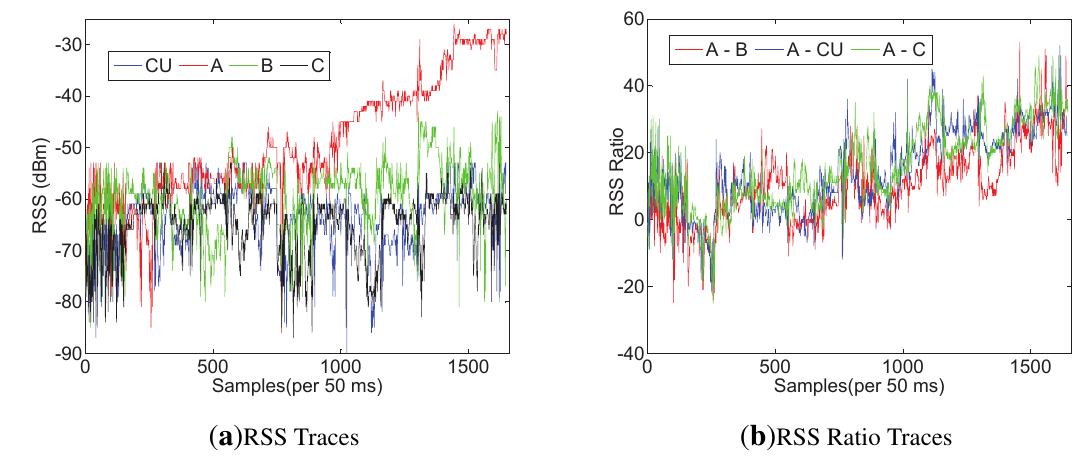
Figure 7. The RSS and RSS ratio of user 2 measured in Plan 2.